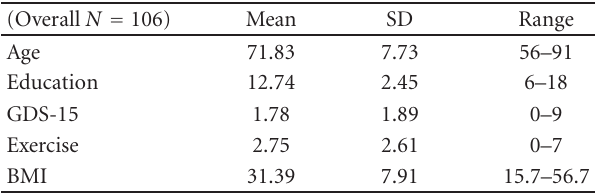
Table 1: Demographic, exercise, BMI and mood characteristics of sample.